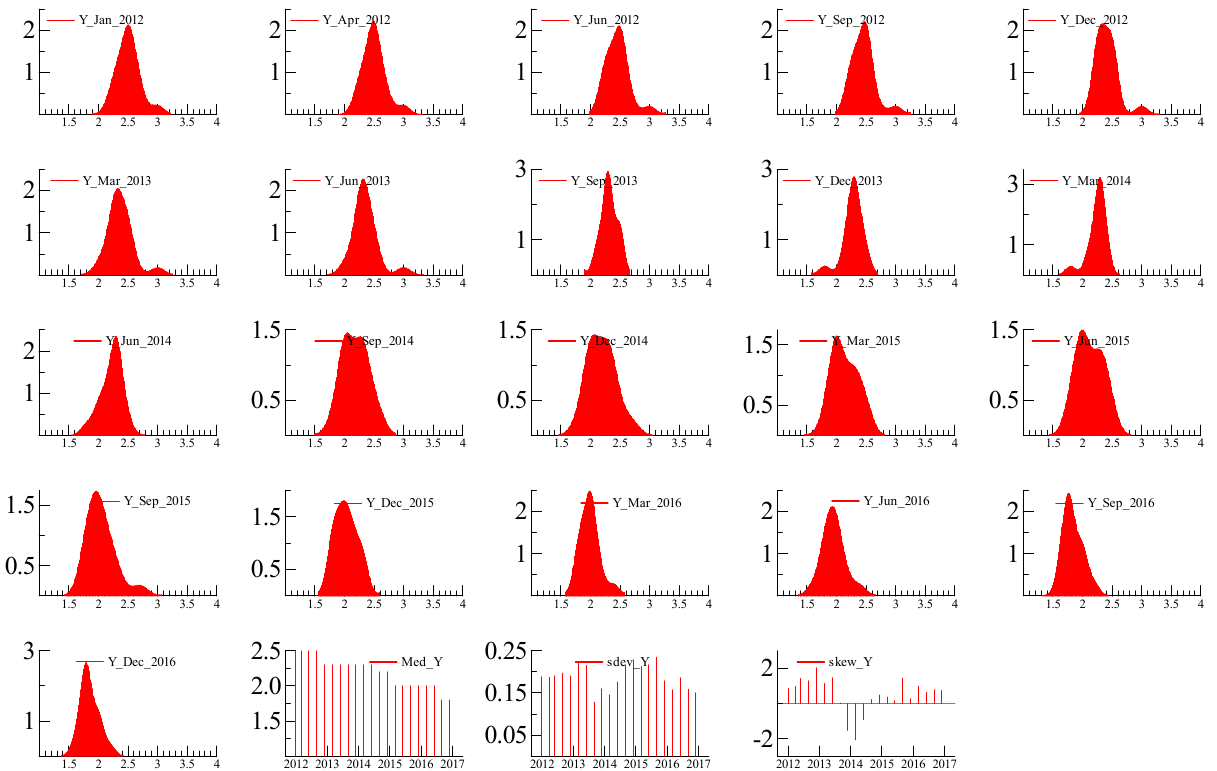
Figure 3. Marginal densities for the FOMC’s longer-run forecast for GDP Growth—January 2012– December 2016. Panels with vertical lines correspond to three moments of the distributions: median, standard deviation, skewness.